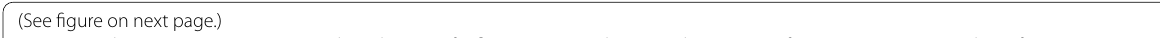
cells (adGFP) (Fig. 5A, B). AdMindin cells and adGFP